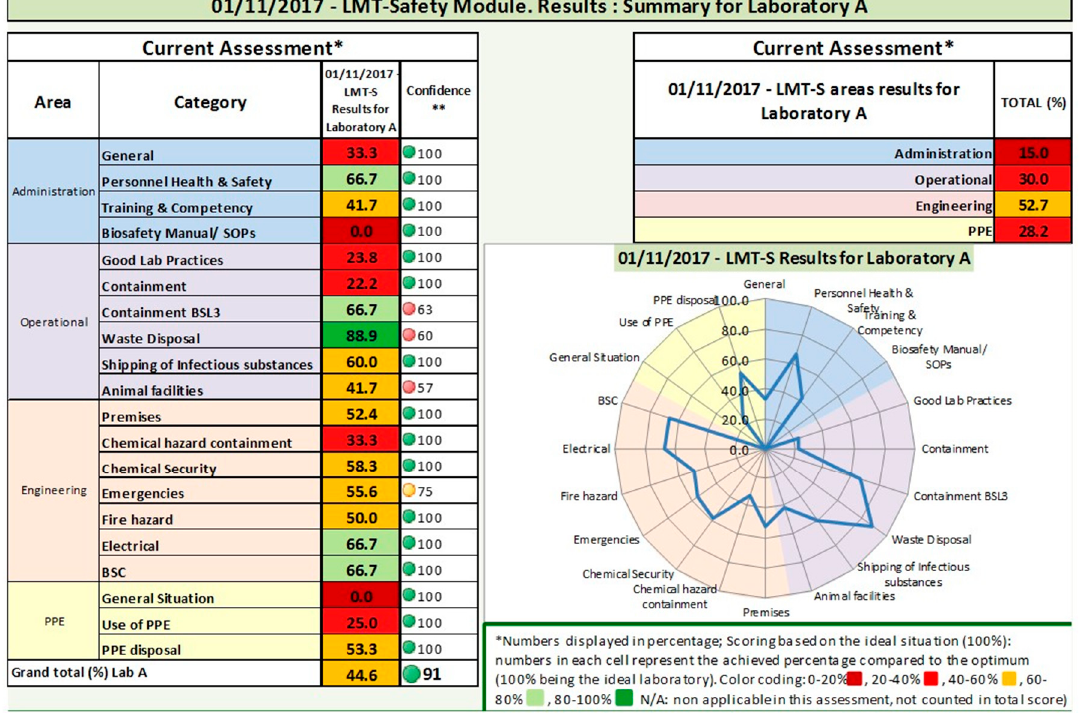
Figure 1. Example of results of an LMT-S assessment conducted in region B.